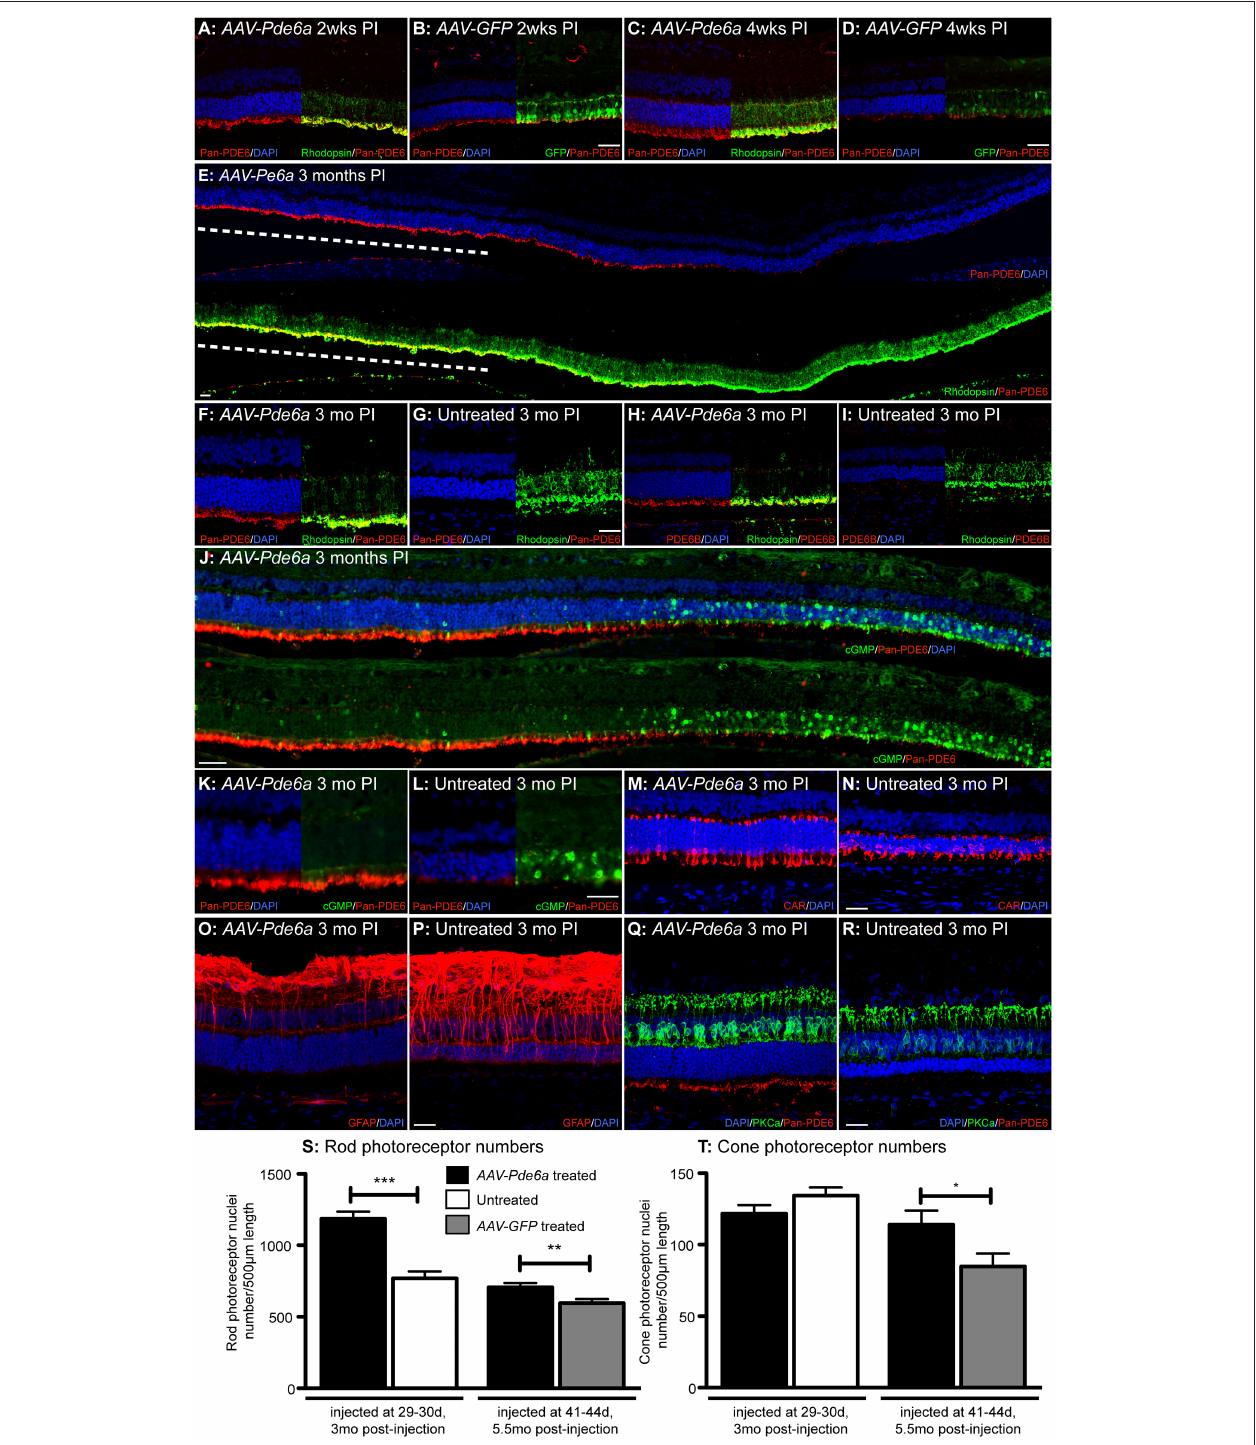
FIGURE 5 | Histological features of Pde6a gene augmentation treatment. Two weeks following injection increased immunolabeling for PDE6 protein was detected in the AAV-Pde6a treated eye (A) , and GFP expression was detected at this stage in the contralateral AAV-GFP injected eye (B) . PDE6 expression was sustained in the AAV-Pde6a treated eye after 4 weeks (C) but very little was detected in eyes treated with AAV-GFP (D) . Three months following treatment with AAV-Pde6a , outer segment detection of PDE6 was sustained in the injected area (dashed white line; E ), and there was reduction in the amount of rhodopsin mislocalized into the rod cell bodies in the treated region (F) compared with significant cell body mislocalization in untreated contralateral eyes (G) . Pde6b, a subunit not directly delivered by